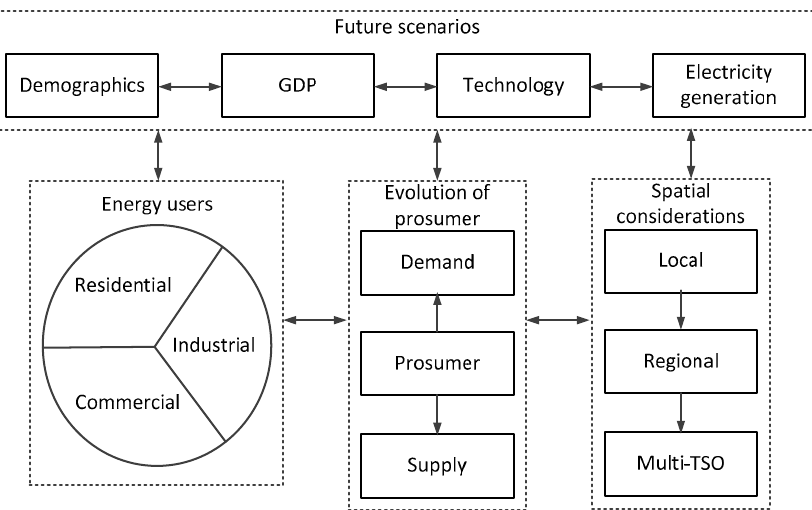
Figure 1. Complexity in long-term electricity load forecast (GDP: Gross Domestic Product, DSO: Distribution System Operator, TSO: Transmission System Operator). Distribution System Operator, TSO: Transmission System